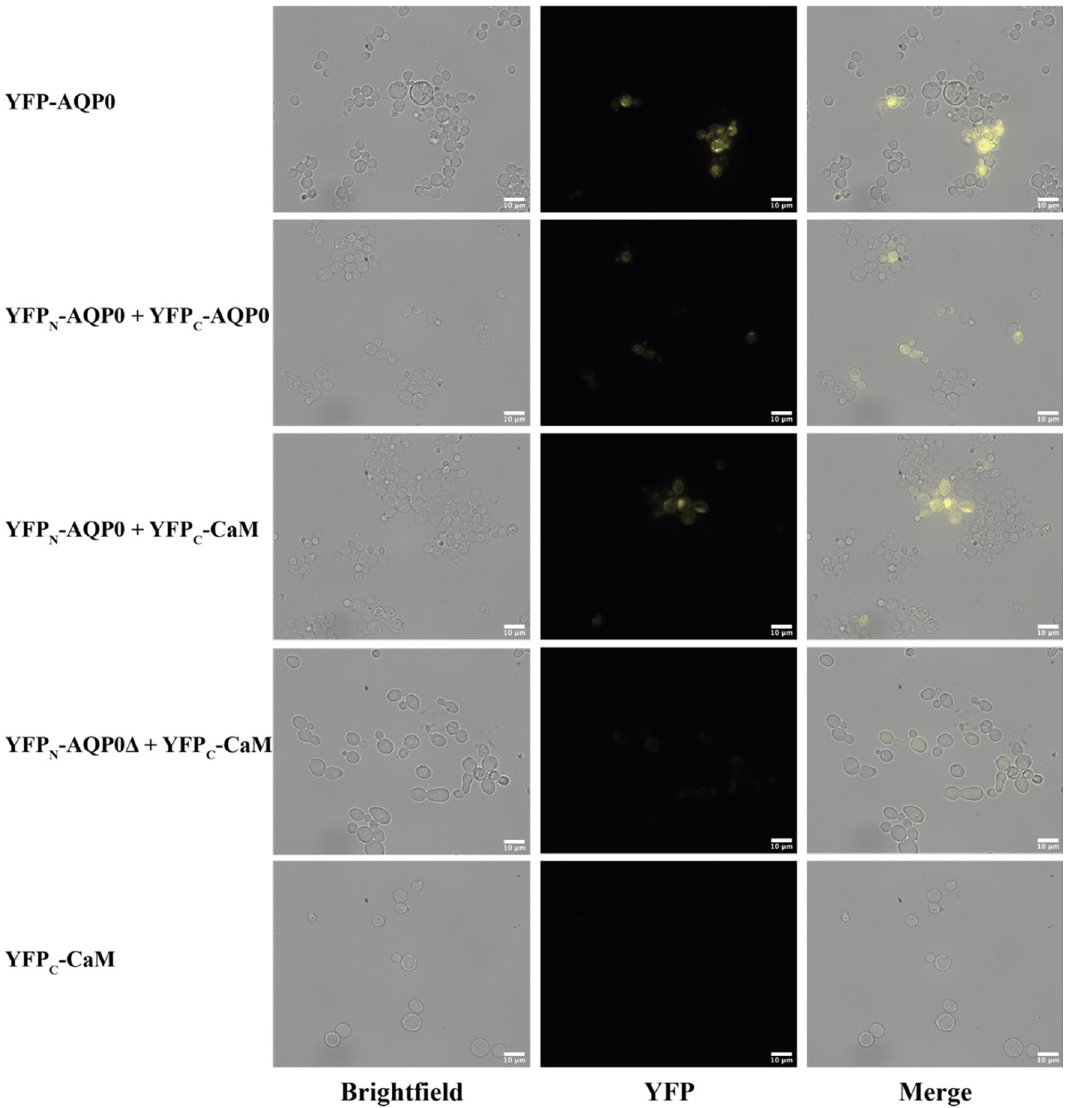
Figure 3. Bright field and fluorescence images of subcellular localisation of BiFC complexes produced in S. cerevisiae cells. Highest fluorescence signal was obtained from the positive control, cells producing the full length chromophore fused to human aquaporin 0, YFP − AQP0. Cells transformed with interaction complexes YFP N − AQP0 + YFP C − AQP0 and YFP N − AQP0 + YFP C − CaM, respectively, showed an intermediate signal, while very faint fluorescence was observed for the C-terminus deficient BiFC formation